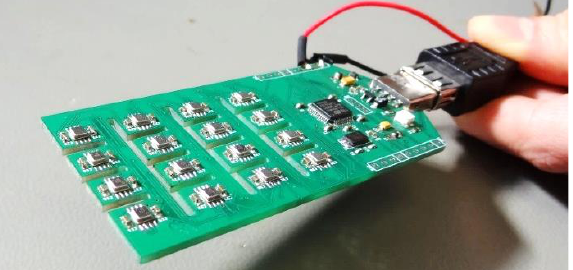
Figure 1. Detail of the custom eNose implementation composed of sixteen single-type MOX gas sensors embedded in sixteen BME680 sensor devices.